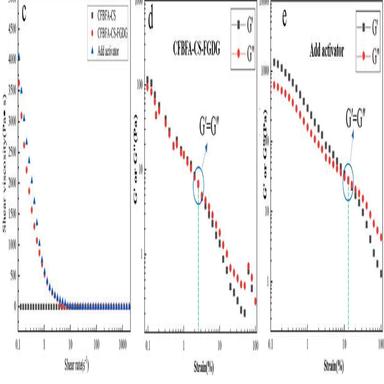
Effect of activator on temperature and rheological properties of composite gelling system (a: temperature measuring equipment, b: temperature change of composite system, c: viscosity of composite system changes with shear rate, d–e: modulus of composite system changes with tension).